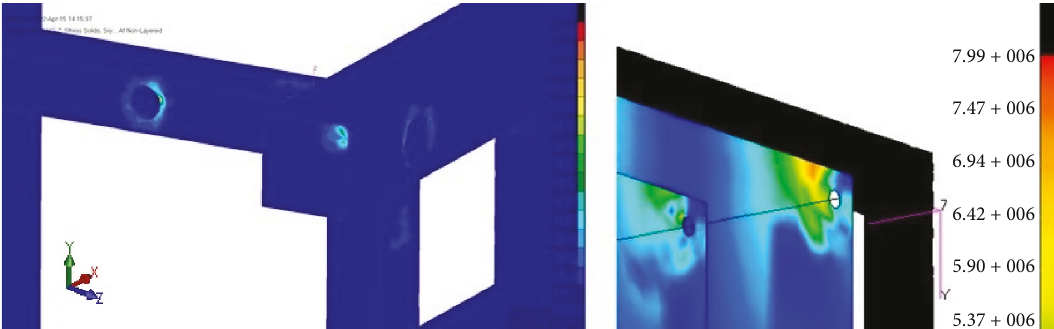
Figure 11: RMS stress distribution (PSD